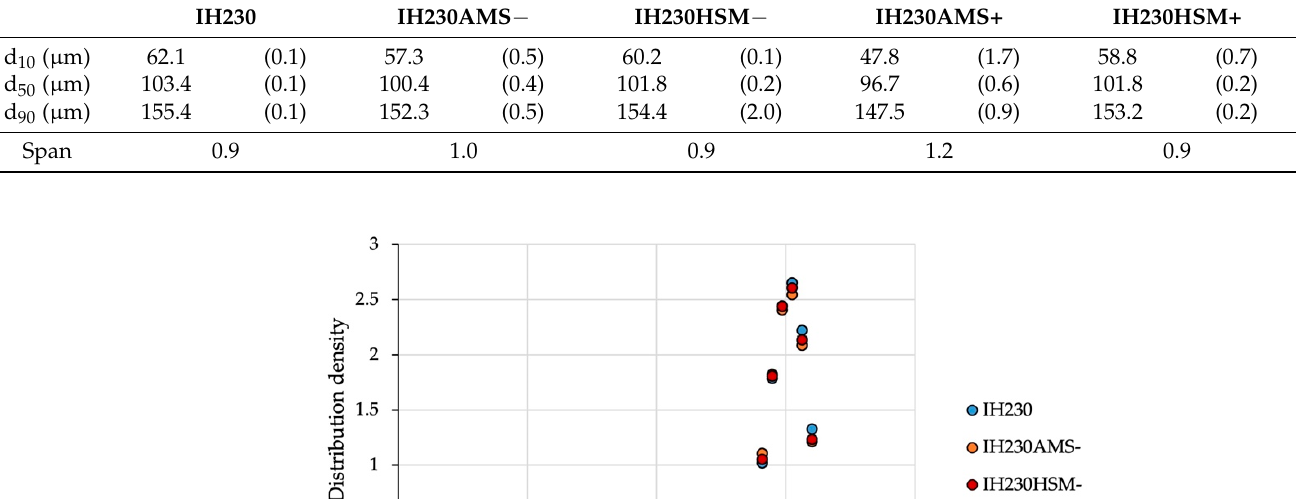
Table 1. Particle size distributions of all investigated materials. n = 3, SD in parentheses.